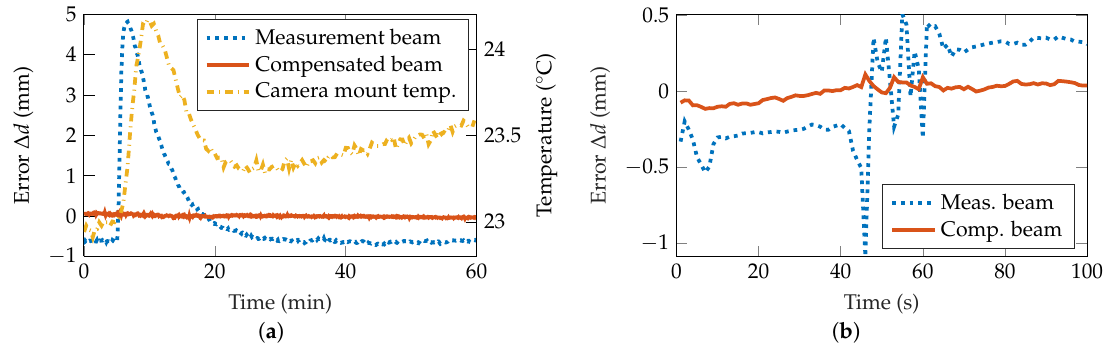
Figure 6. ( a ) A heating resistor at the camera mount was turned on after 6 min for a duration of 30 s. This results in a shift of the MSC due to the thermal expansion, whereas the compensated beam position is not affected. ( b ) Due to mechanical vibrations at the optical table the measurement beam position shows a movement, whilst the impact is strongly reduced in the compensated beam